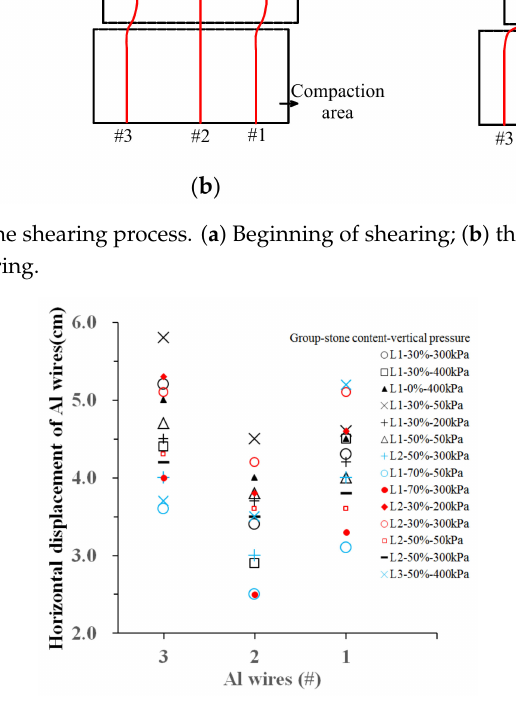
Figure 9. Horizontal displacement of Al